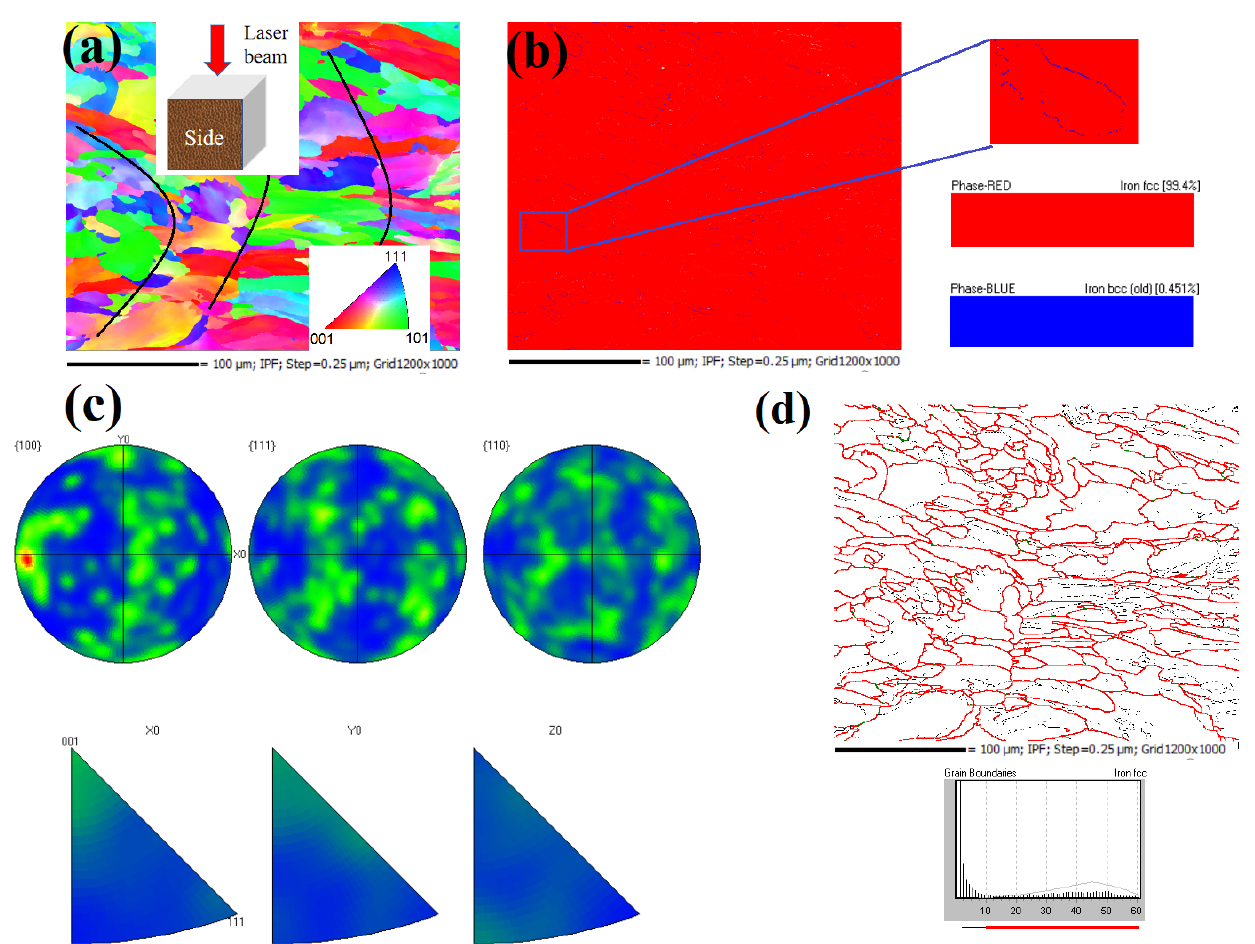
Figure 7. EBSD pattern: ( a ) orientation, ( b ) phase distribution, ( c ) pole and inverse pole, and ( d ) grain boundary of the SLM samples.